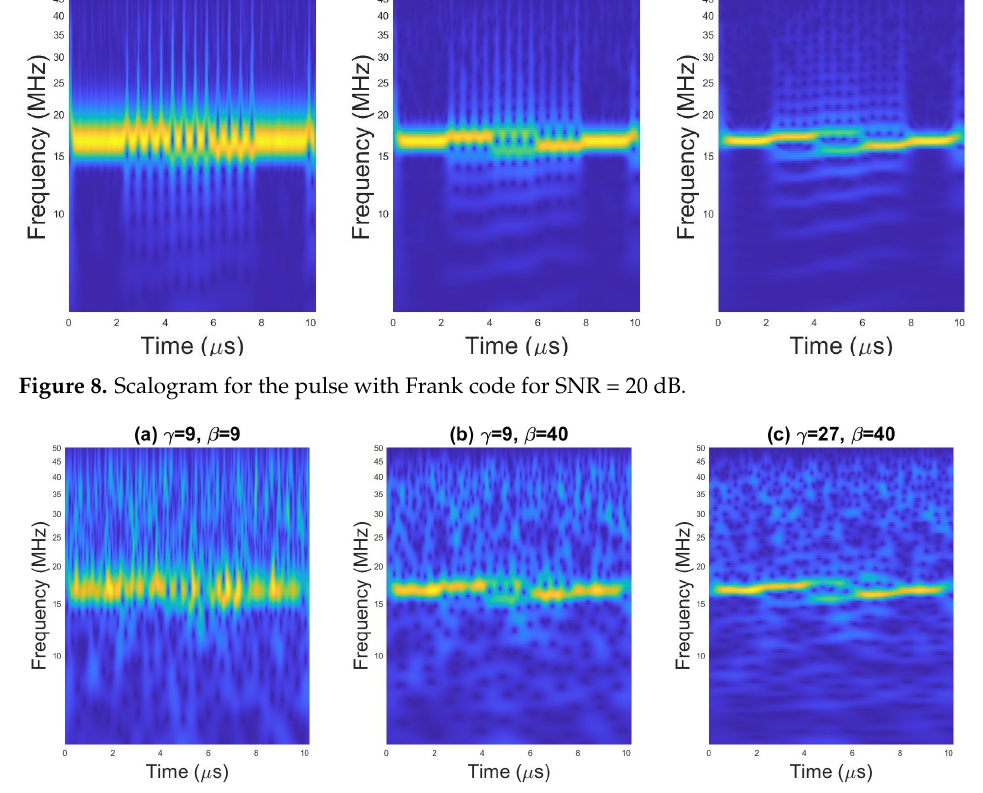
Figure 9. Scalogram for the pulse with Frank code for SNR = 0 dB.